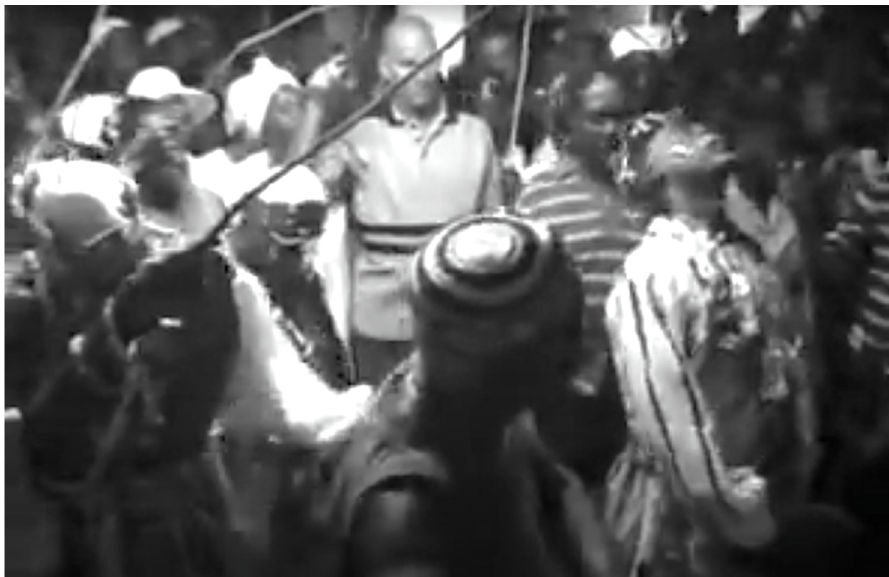
Figure 5. Still from Vamos al tambor (2003). Courtesy of Kabiosile Productions.